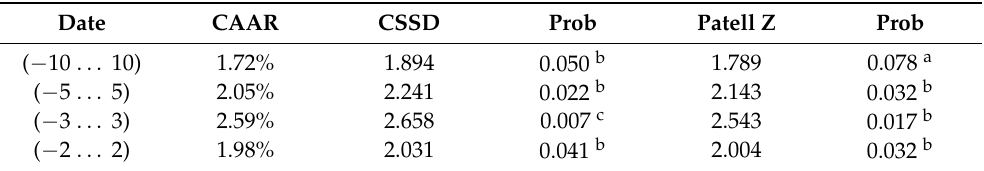
Table 2. Results of parametric tests.